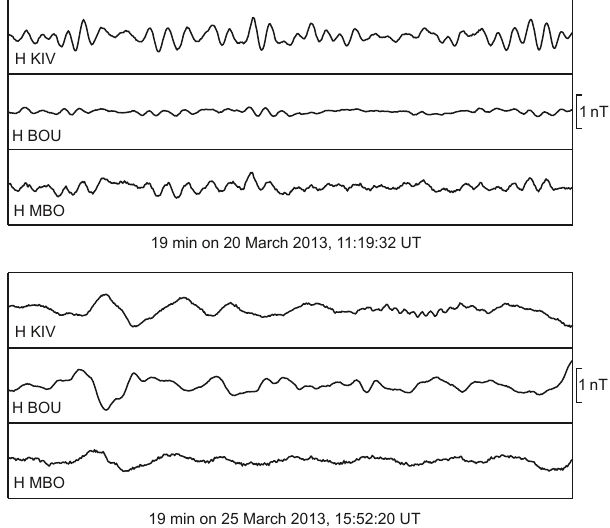
Figure 5. Two examples of highly coherent synchronous time se- ries between KIV, BOU, and MBO H components. The upper part shows pulsations in the pc3 range which originate most probably from upstream waves. The example belows contains pc5 pulsations to the left, probably from another global source mechanism. The time series are high-pass filtered with a cut-off period of 300s. Figure 6. xx element of the inter-station transfer function between